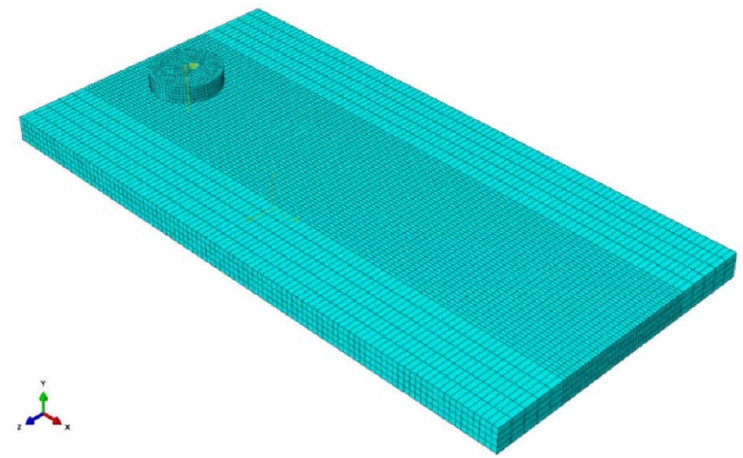
Figure 7. The welding tool including the part and the mesh.